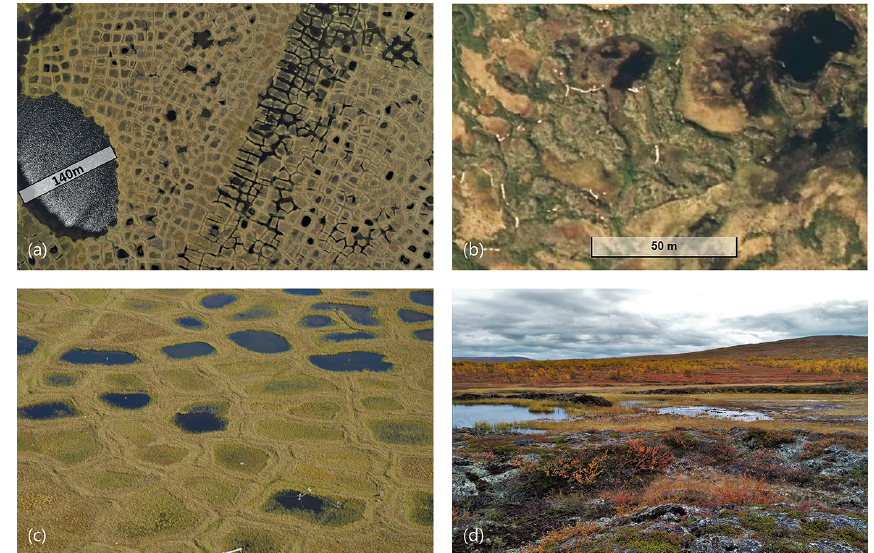
Figure 1. Ice wedge polygons at Samoylov ( a, c , credit to Julia Boike for the images) and palsas and mire at Iškoras ( b , © Kartverket, https://www.norgeskart.no/; d , credit to Noah D. Smith for the image) showing repetitive microtopography and some surface ponding. The observed low-centred polygons at Samoylov were on average 9.1m in diameter and had rims 0.38m above the centre. The observed palsa at Iškoras was 0.68m above the mire. Some polygon rims can reach 1m in height, while Palsas can reach larger elevations of around to 3m.